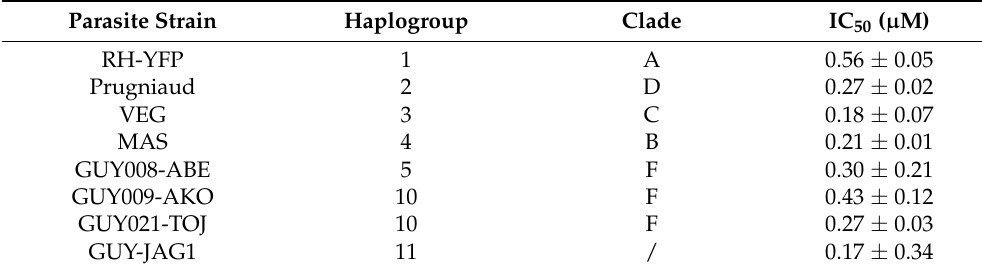
Table 1. In vitro IC 50 of JF363 ascertained against Toxoplasma with a wide range of genotypes and belonging to 7 of the 16 haplogroups described. IC 50 data are the mean ± SD of 3 independent experiments.